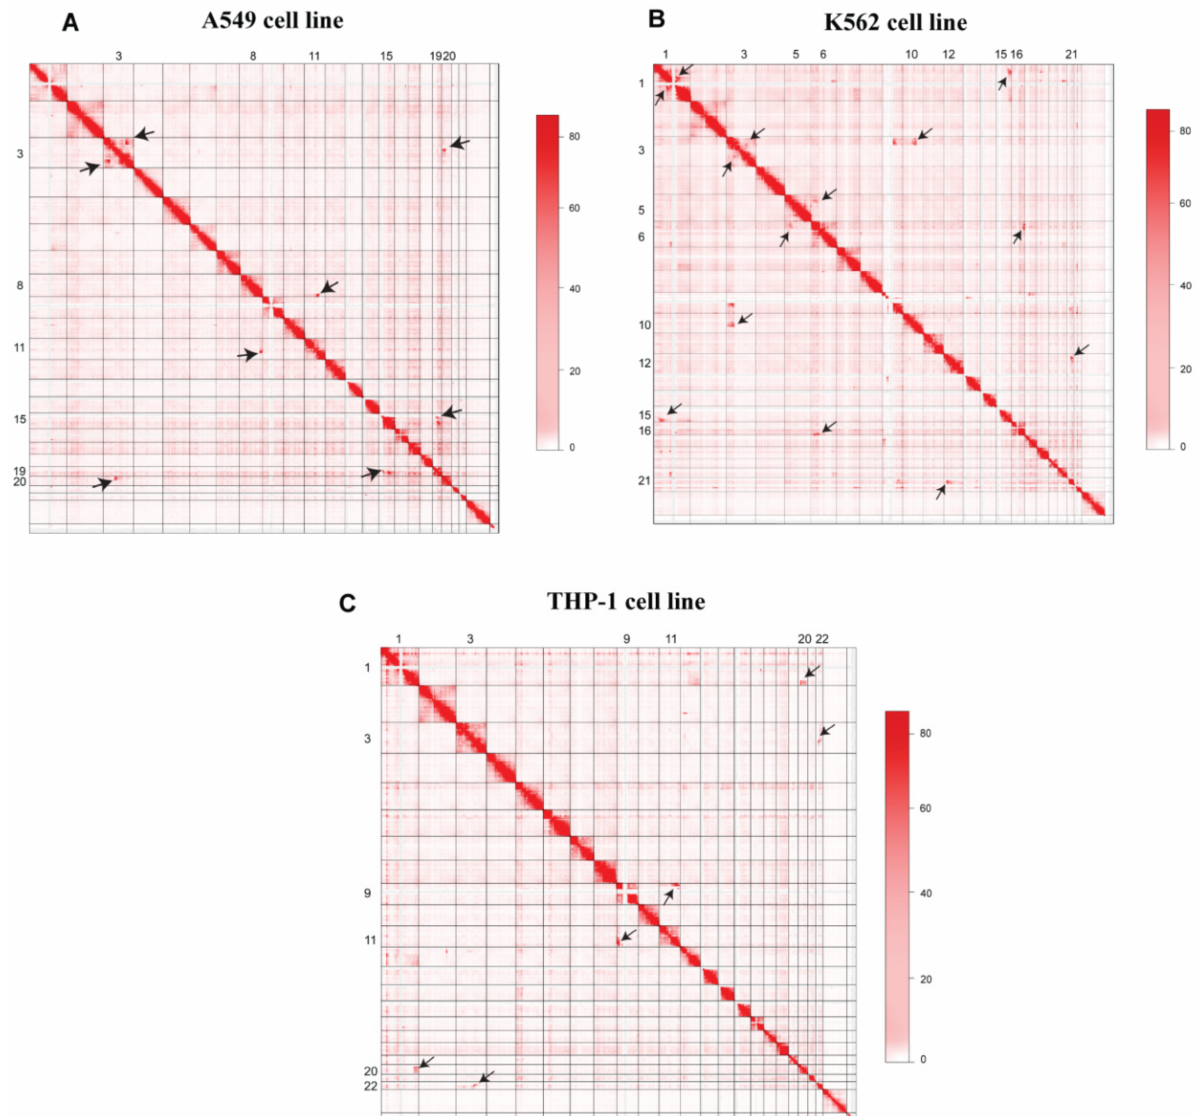
Figure 2. Hi-C maps of A549, K562, and THP-1 3D-genome. ( A ) Heatmap showing the chromosomal interaction in A549 cell line, ( B ) Contact matrix representing the 3D-Genome of K562 cell line, and ( C ) Heatmap representing THP-1 cell line 3D-genome. Different rearrangements were observed and marked with black-headed